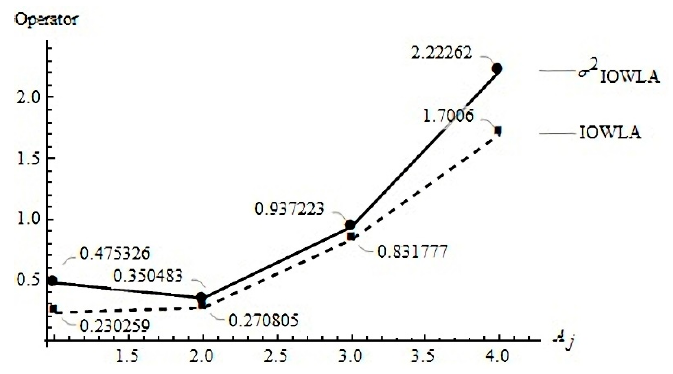
Figure 5. IOWLA and σ 2 IOWLA operators following conditions in Example